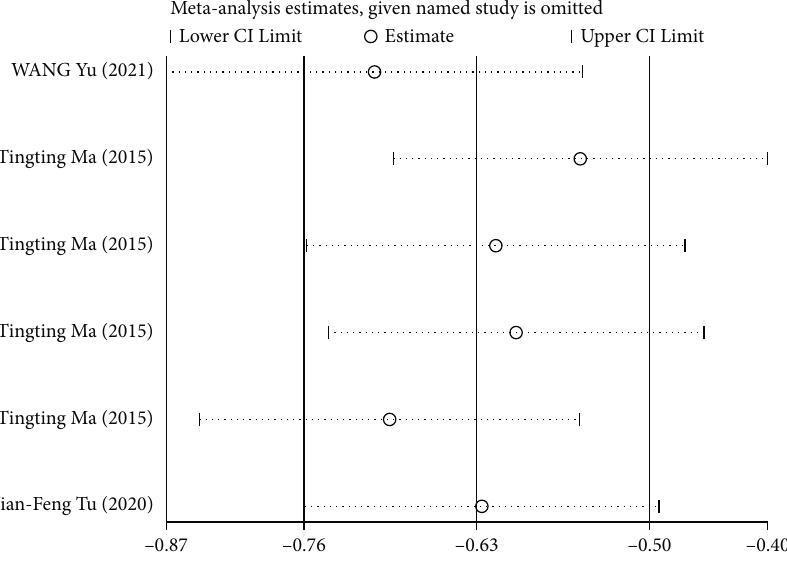
Figure 9: Forest plot of comparison. Acupuncture vs. sham acupuncture. Outcome: change in early satiety from baseline score to week 4. Meta-analysis estimates, given named study is omitted